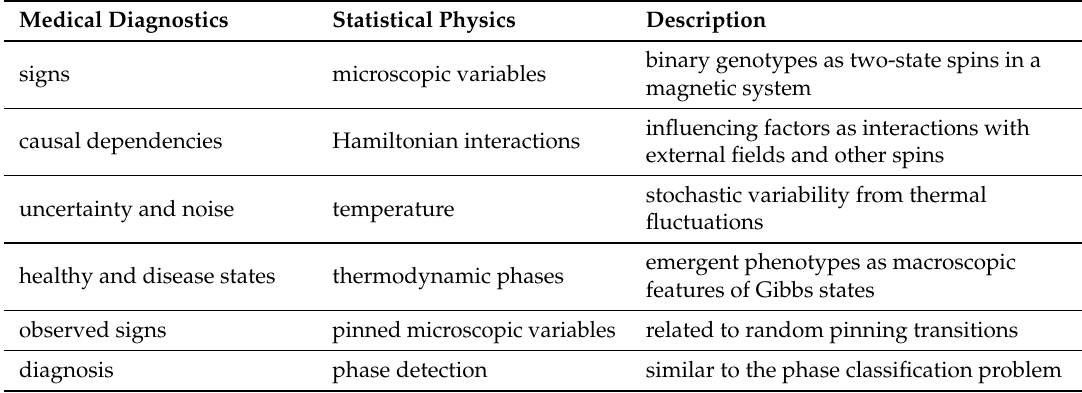
Table 1. An analogy between the main concepts of medical diagnostics and statistical